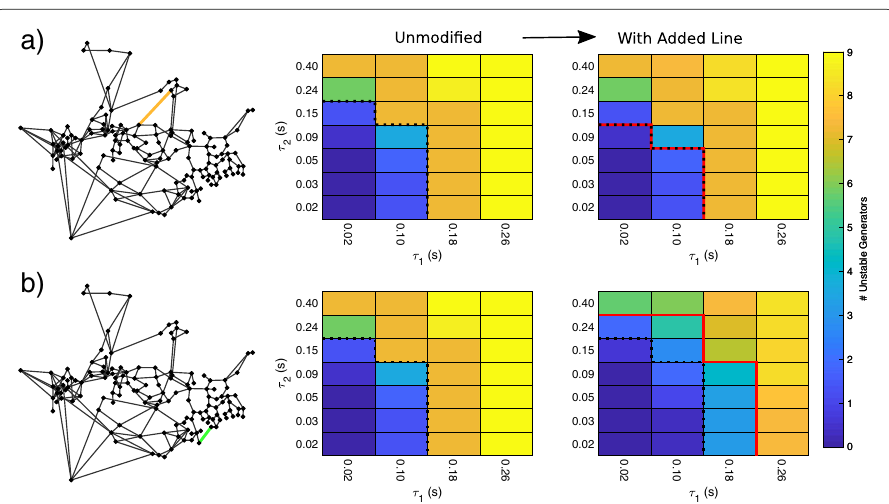
Fig. 8 Instability Frontiers of Modified Networks. For each line addition considered (connections highlighted in color on the left), the mean instability frontier of the unmodified network (center, dotted black line) was compared to that of the network with the new connection (right, solid red line). Some candidates afforded little to no improvement (( a ), with added line in orange), while others robustified the network so that it was resilient to considerably more severe faults (( b ), with added line in